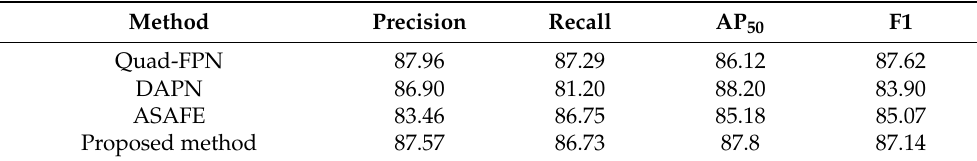
Table 5. Comparison of current SAR ship detection methods on the HRSID dataset.